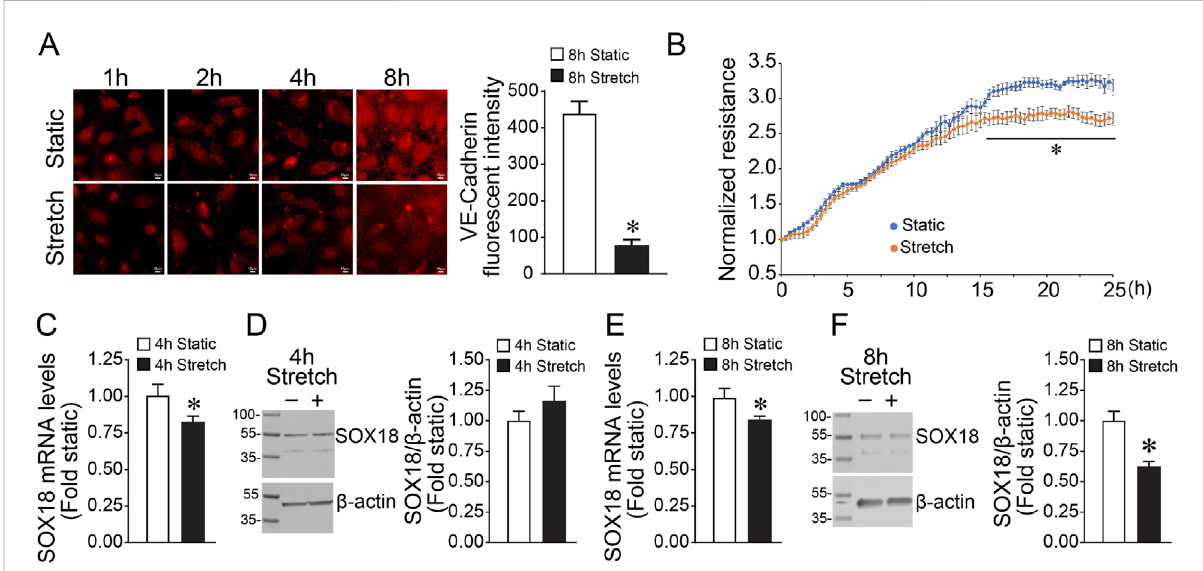
FIGURE 1 Exposing human lung microvascular endothelial cells to pathologic cyclic stretch reduces Sox18 expression. HLMVECs were analyzed by immuno fl uorescent staining using aVE-cadherin antibodyafter being subjectedto 18% cyclic stretch for 8 h, replated on coverslips, and fi xed atthe indicated times. mRNA from HLMVECs were subjected to cDNA synthesis and SYBR green qRT-PCR using speci fi c primers directed to SOX18 sequence and normalized to Beta-2-Microglobulin, a housekeeping gene. Protein extracts prepared from HLMVECs were immunoblotted using SOX18 antibody. VE-cadherin is reduced in the HLMVECs subjected to cyclic stretch (A) . Transendothelial resistance recovery is signi fi cantly diminished in cells stretched at 18% for 8 h (B) . qRT-PCR analysis demonstrated a signi fi cant decrease of SOX18 mRNA after cyclic stretch (C,E)